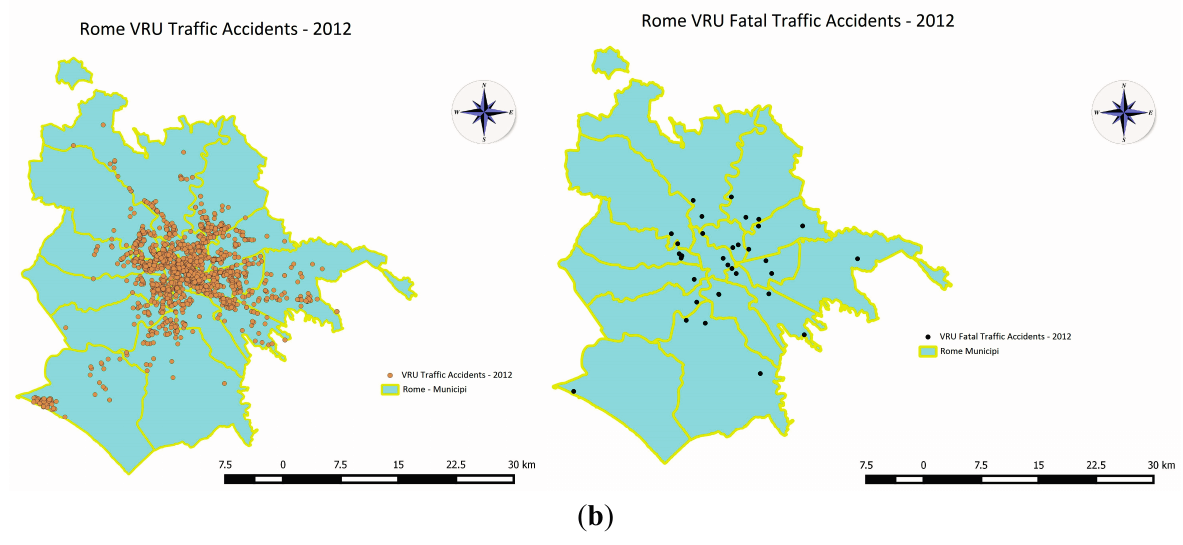
Figure 4. ( a ) Vulnerable road user (VRU) traffic accidents in São Paulo; ( b ) VRU traffic accidents in